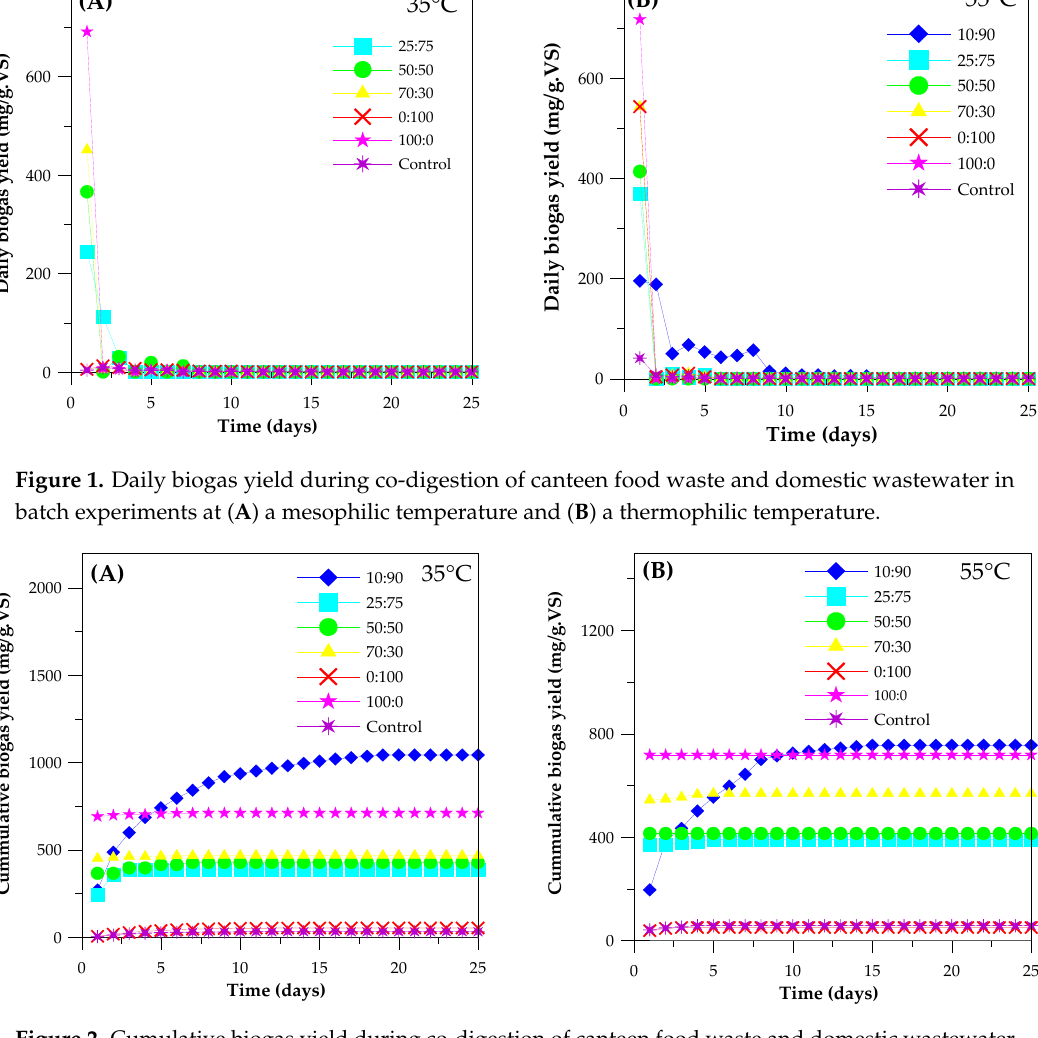
Figure 2. Cumulative biogas yield during co-digestion of canteen food waste and domestic wastewater in batch experiments at ( A ) a mesophilic temperature and ( B ) a thermophilic temperature. Table 2. Performance data for batch experiments with various ratios of co-substrate under mesophilic (35 ° C) and thermophilic (55 ° C) conditions.